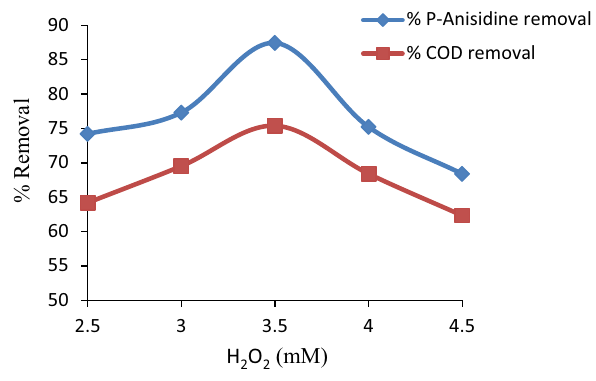
Fig. 4 Effect of H p -anisidine degradation during Fenton’s oxi- 2 O 2 on dation